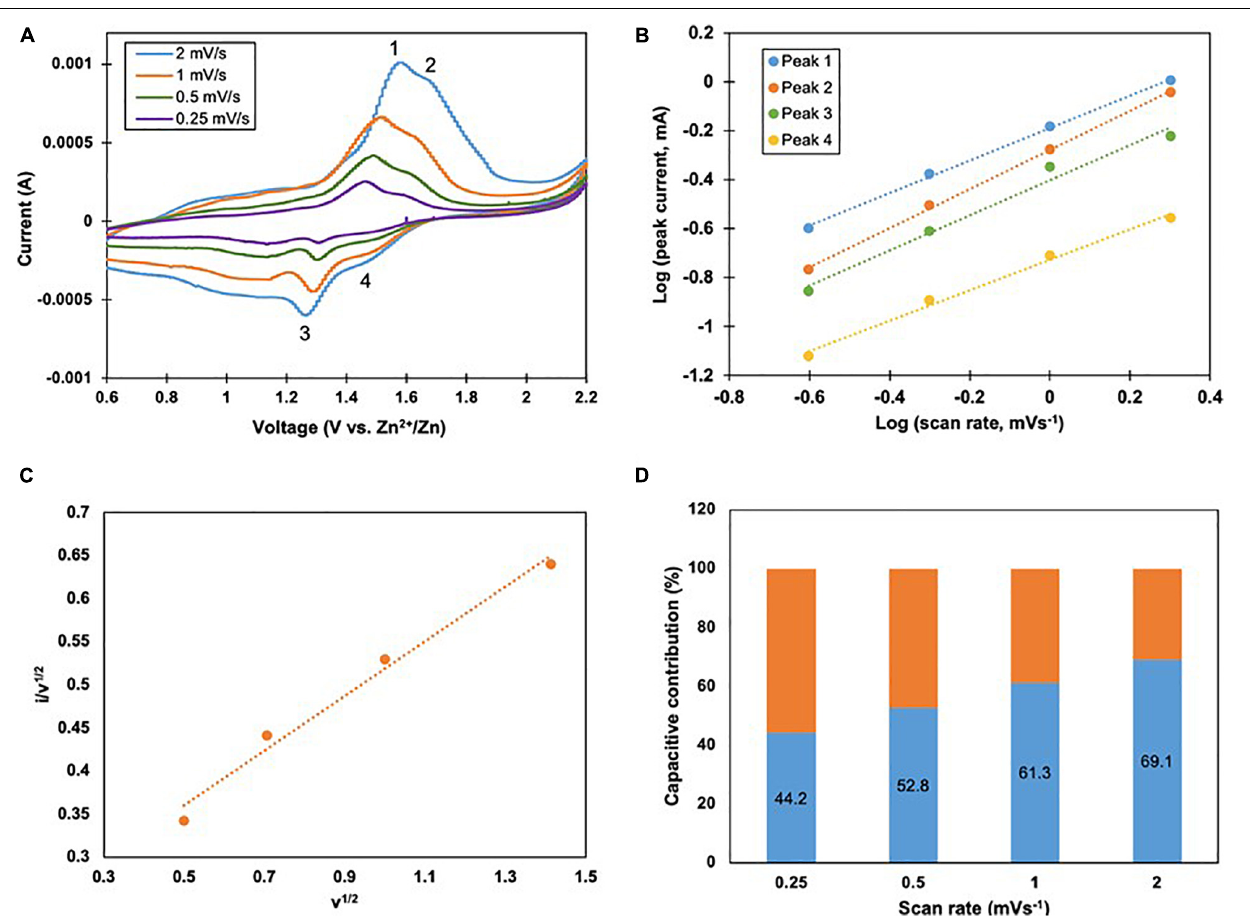
FIGURE 9 | Kinetic analysis of Zn 2 + storage in VOP2, (A) Cyclic voltammograms at different scan rates, (B) Logarithmic plots of peak current against scan rate of each peak, (C) Plot of i/v 1 / 2 vs v 1 / 2 for peak 2. (D) Capacitive contributions at 0.25 to 2 mVs 1 {blue region).